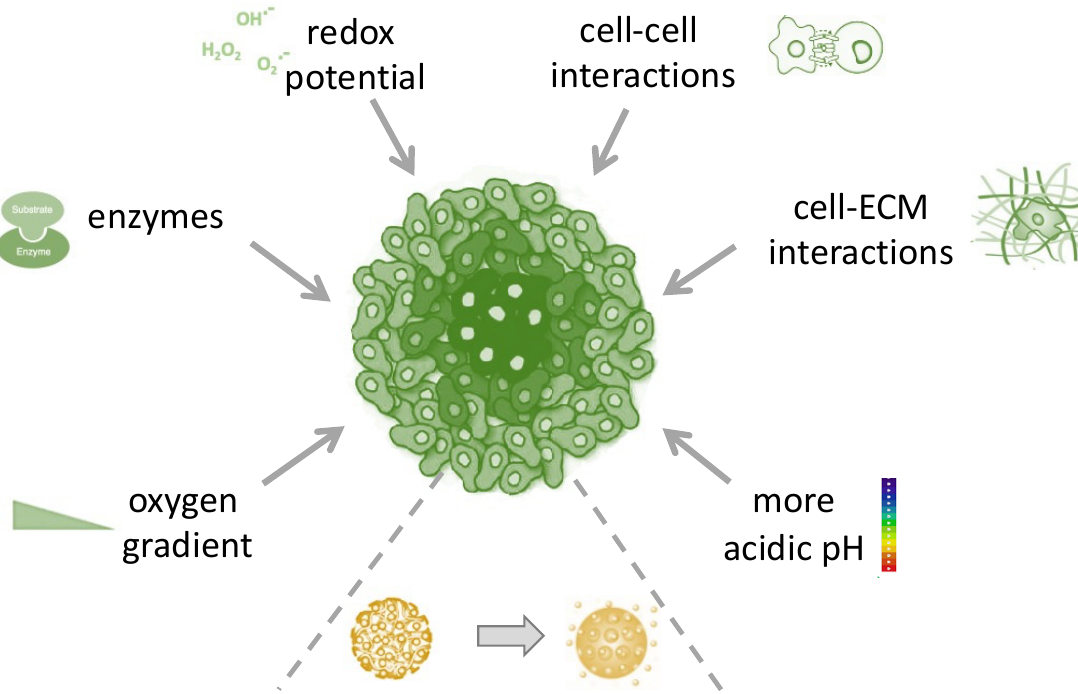
Figure 1. Endogenous triggers for site-specific delivery of drugs by stimuli-responsive drug-delivery systems.